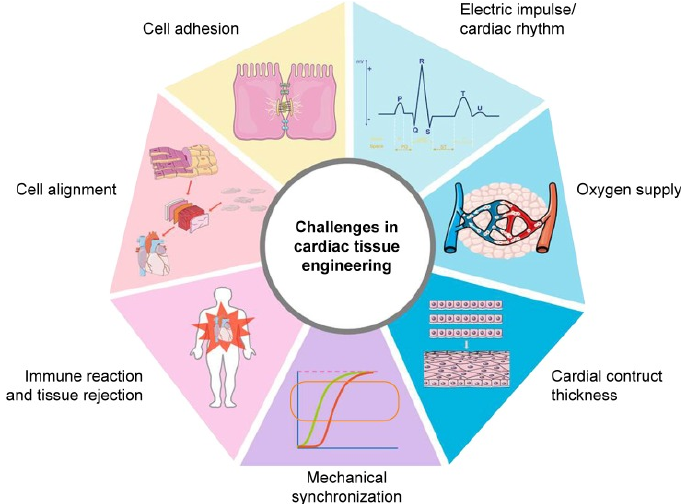
Figure 1. Graphical representation of challenges in cardiac tissue engineering. Reprinted with permission from ref. [35]. Copyright 2018, Dove Medical Press.